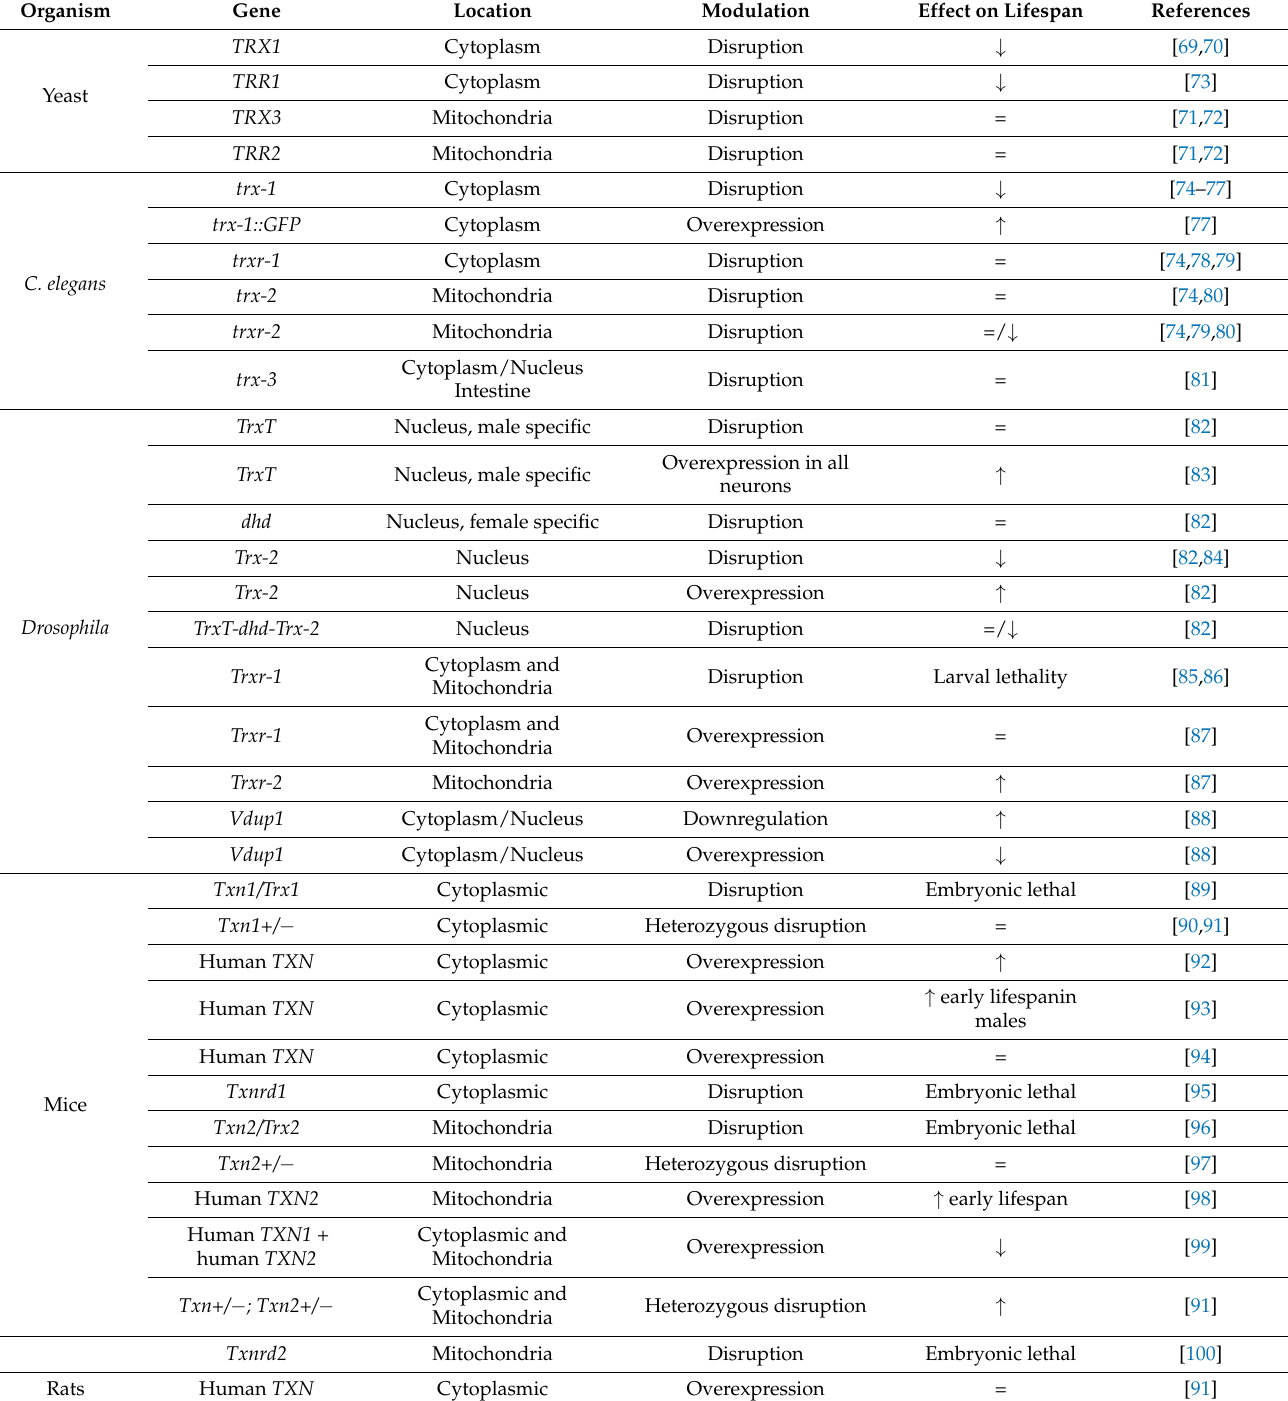
Table 1. Effect of thioredoxin systems on lifespan in model